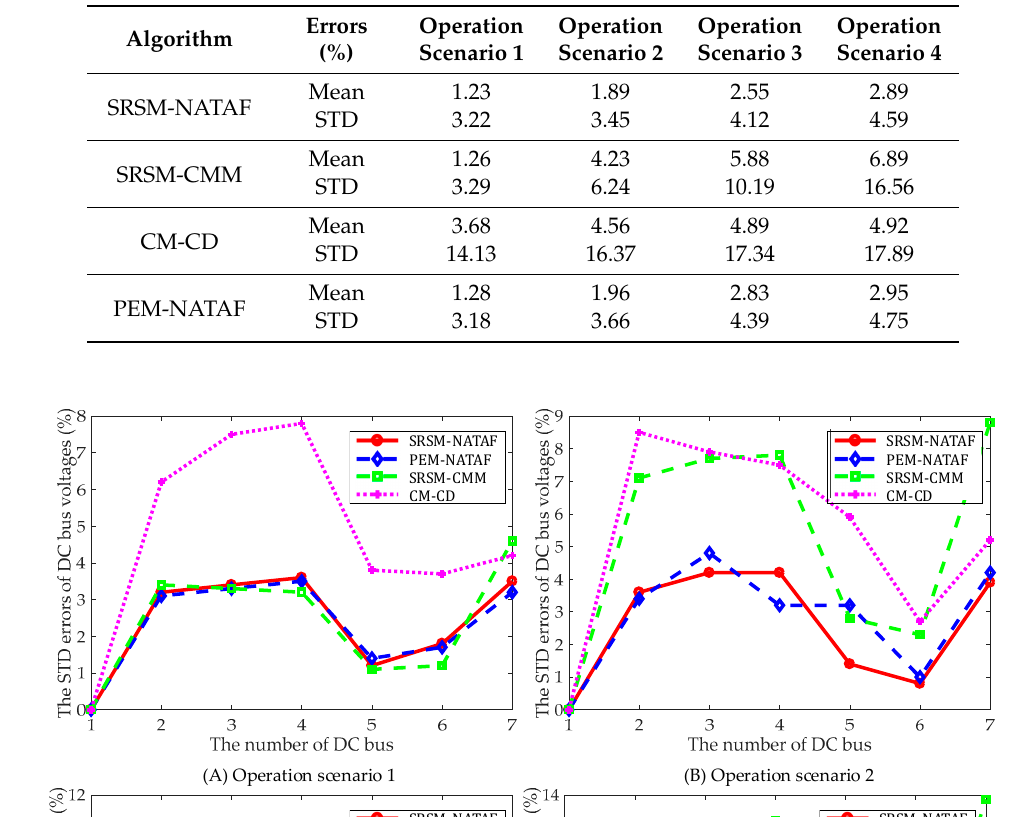
Table 5. The average errors of mean values of the DC bus voltages in the four different operational scenarios examined. Table 6. The errors of the mean and standard deviation values of the active power losses from the AC grid in the four different operational scenarios examined.